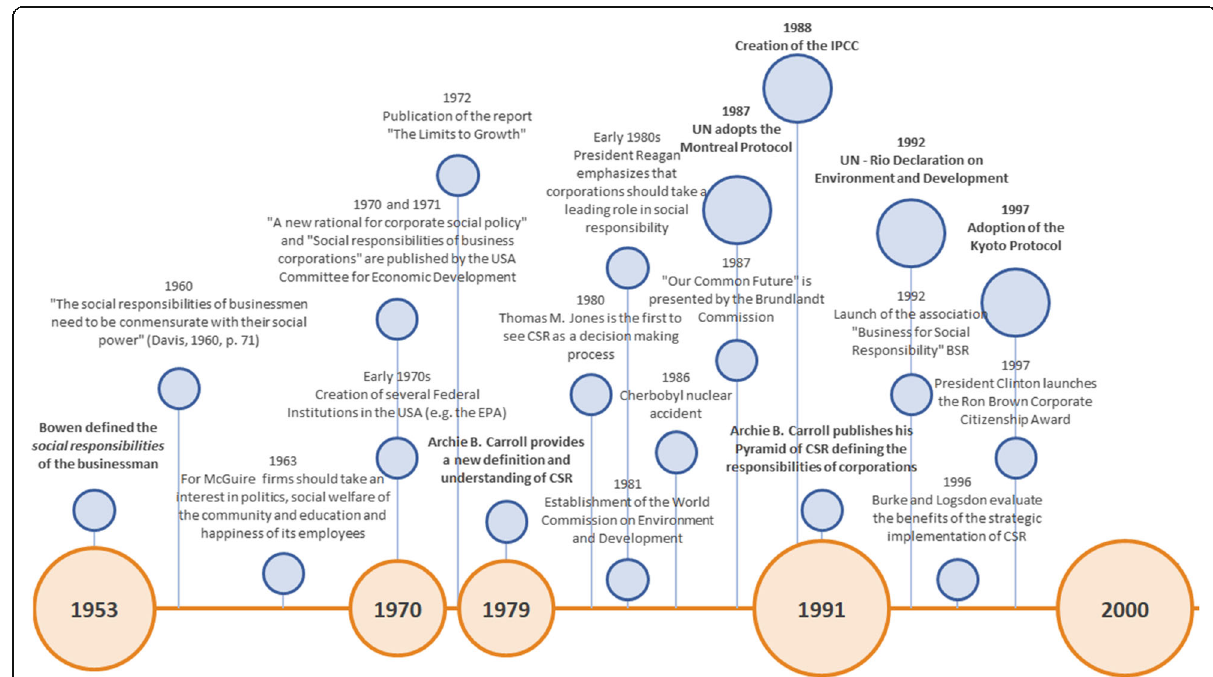
Fig. 2 Visual history of CSR (Part 1 of 2). Source: Developed by the authors based on this literature review. Note: the size of the circles is a subjective representation of the level of influence each aspect had on the evolution of CSR. Hence, a bigger circle represents a higher level of